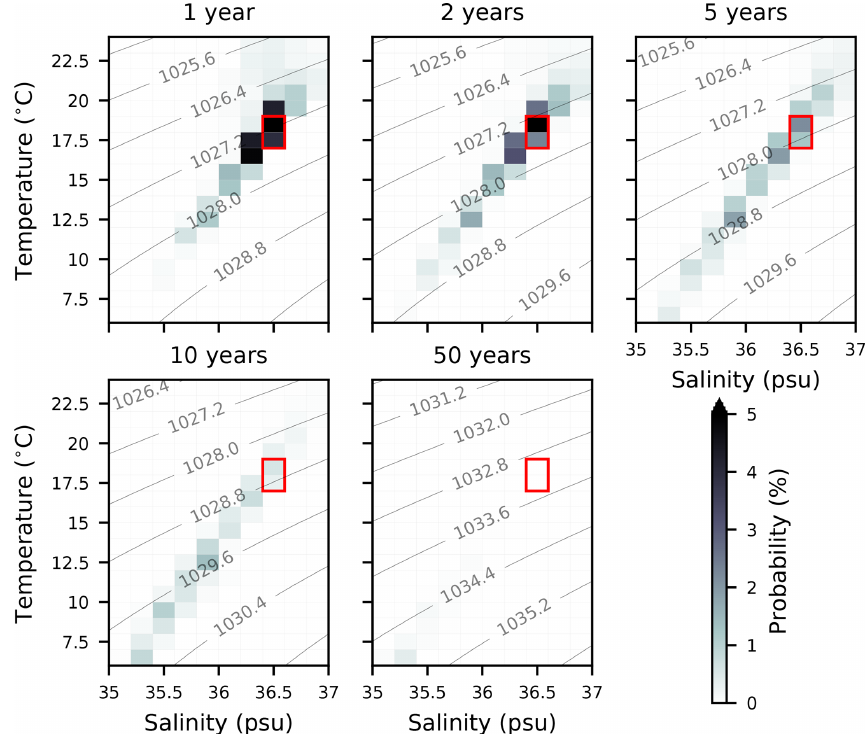
Figure 7. Evolution of model NASMW in TS space. Shading indicates likelihood that the water mass found in a particular TS class after 1, 2, 5, 10, and 50 years. The red box marks the TS range used to define the water mass in this study. Contours show the density at the average depth level of the